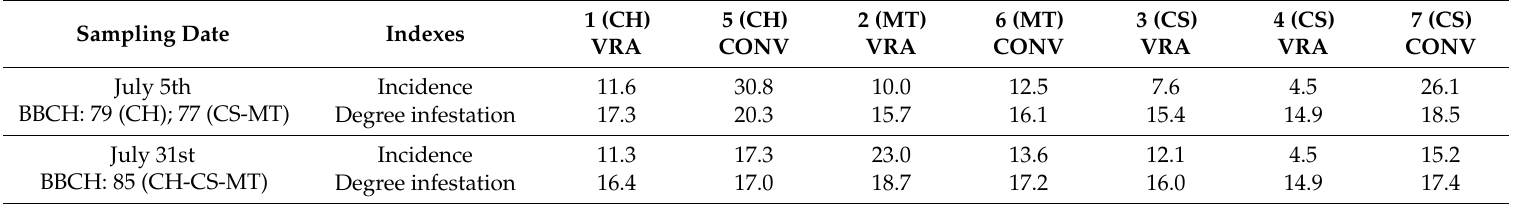
Table 7. Percentage of incidence and degree infestation of powdery mildew at two sampling dates for conventional (CONV) and variable rate application (VRA)